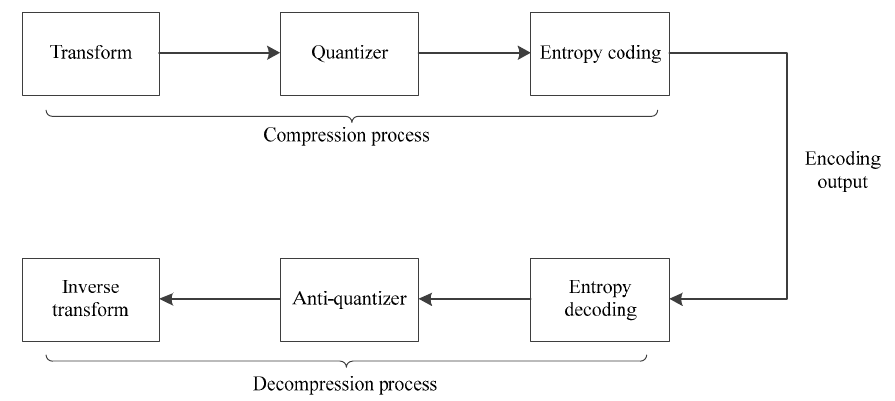
Figure 1. Block diagram of data compression and decompression.